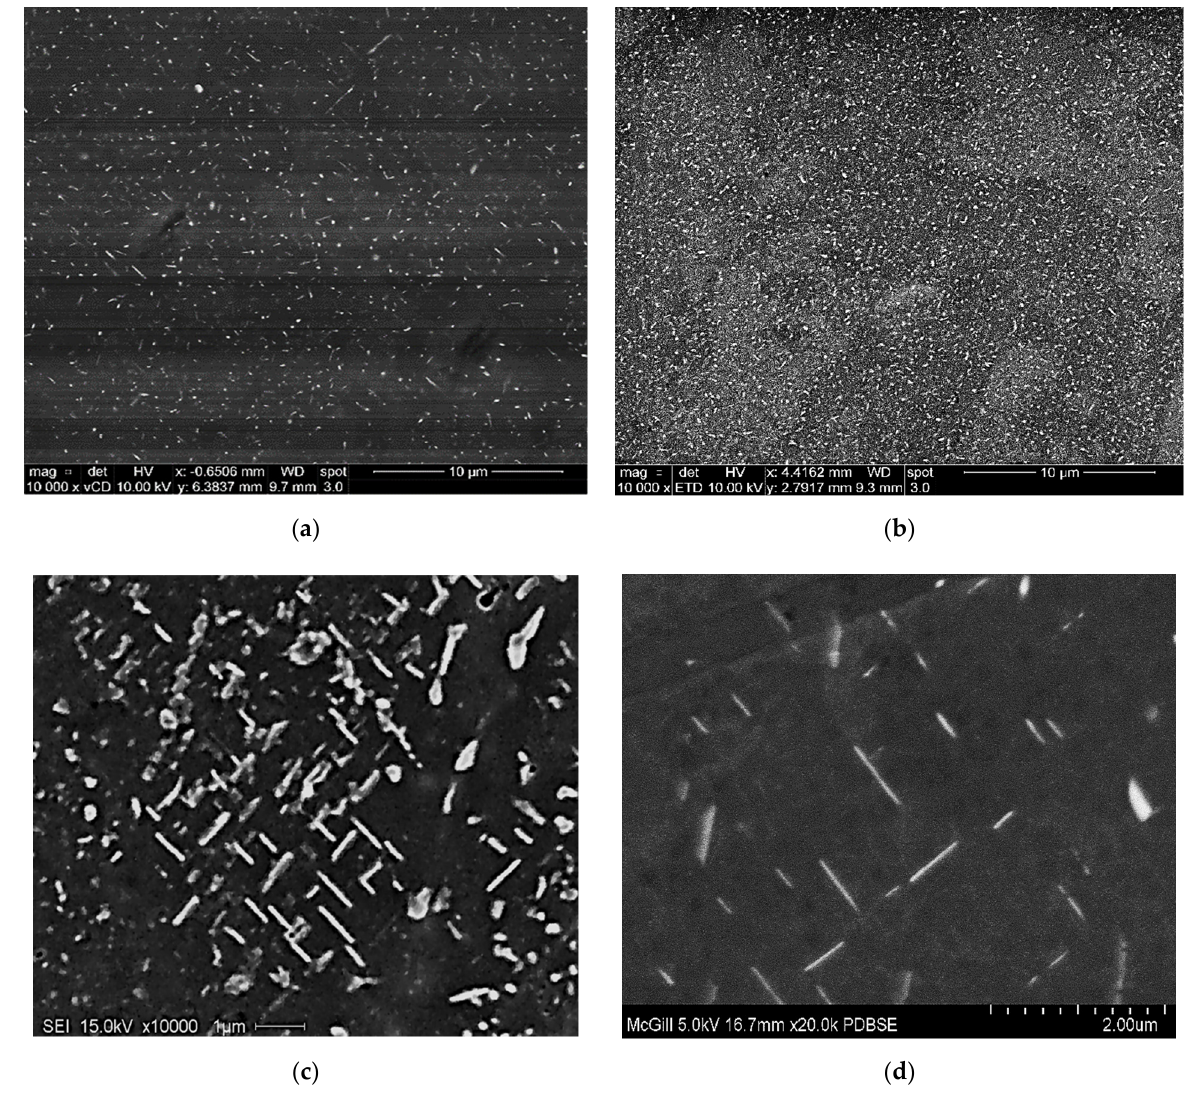
Figure 9. Electron images showing precipitation observed in alloy 220M at ( a ) 180 °C—at 10,000×; ( b ) 220 °C—at 10,000×; ( c ) 300 °C—at 10,000×; and ( d ) 300 °C—at 20,000× magnification.